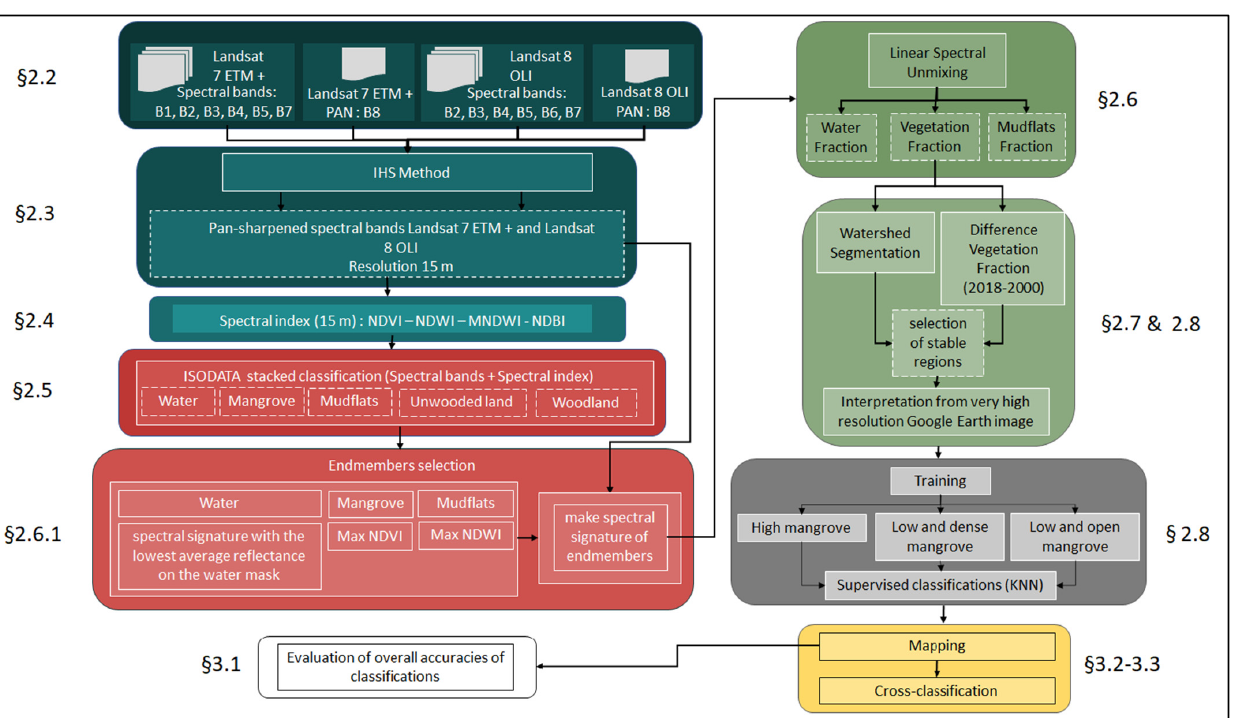
Table 2. Summary of the partition for the training and validation data of the classification (in pixels). Saloum Casamance Training Control Training Control high mangrove 1109 1055 1812 1335 low and dense mangrove 1827 891 2213 2344 Low and open mangrove 1382 1002 2620 1863 Total (pixel) 7266 12,187 The flowchart in Figure 5 compiles the different steps of the methodological chain.